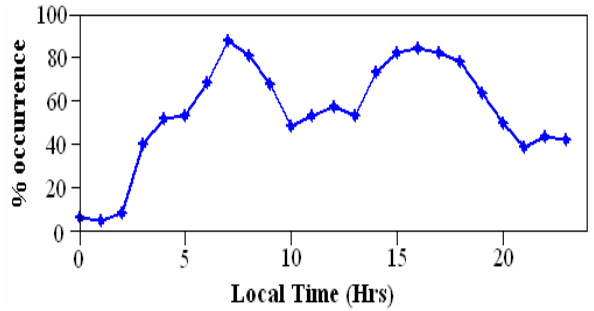
Fig. 5. Percentage occurrence of blanketing E s as a function of time.